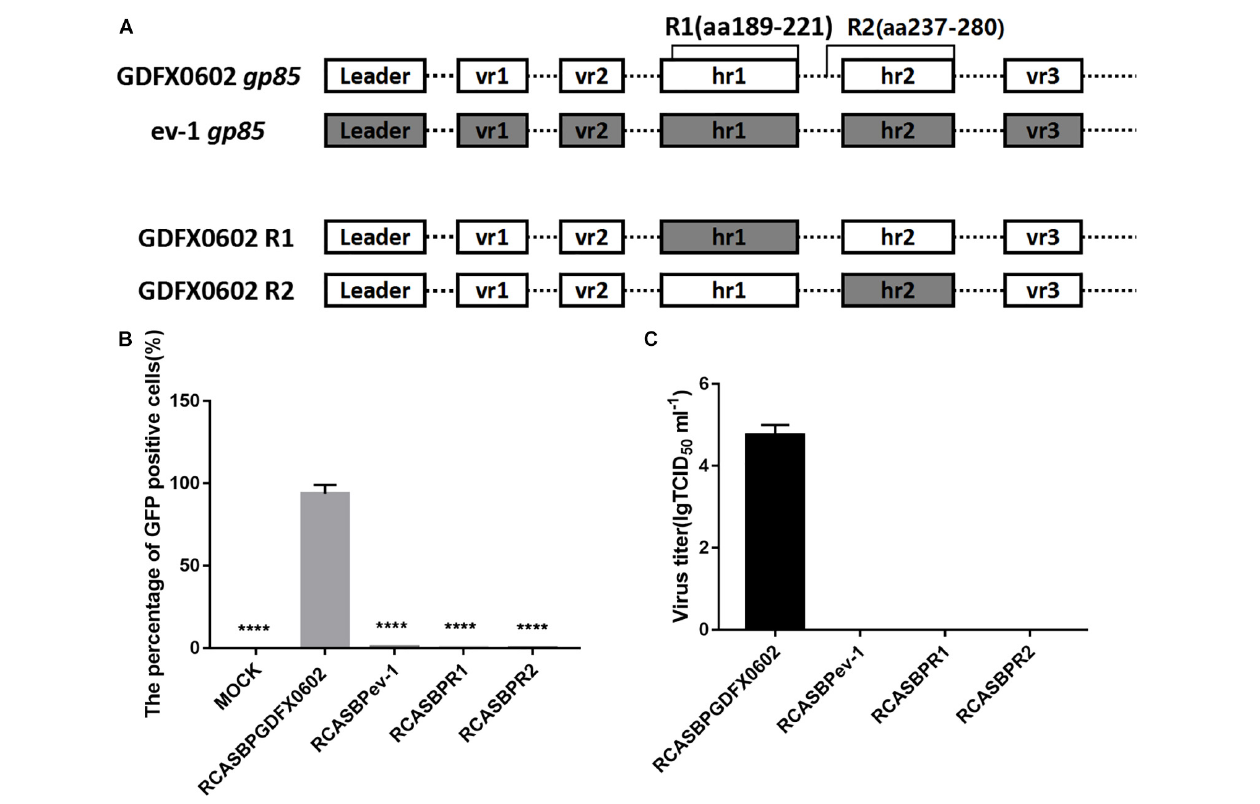
FIGURE 3 | Both residues R1 (aa189–221) and R2 (aa237–280) affected the ability of ALV-K to infect DF-1 cells. (A) The relationship between R1, R2, and regions hr1 and hr2. (B) DF-1 cells transfected with recombinant plasmids RCASBPGDFX0602-enhanced green fluorescent protein (EGFP), RCASBPev-1-EGFP, RCASBPR1-EGFP, and RCASBPR2-EGFP were detected for the percentage of GFP-positive cells by fluorescence-activated cell sorting. (C) The supernatant was collected and diluted in gradient to determine the virus titers. Three independent experiments were performed, and data are shown as mean ± SD in triplicate from a representative experiment. Statistical analysis (two-way analysis of variance) was performed using GraphPad Prism 7; **** P <